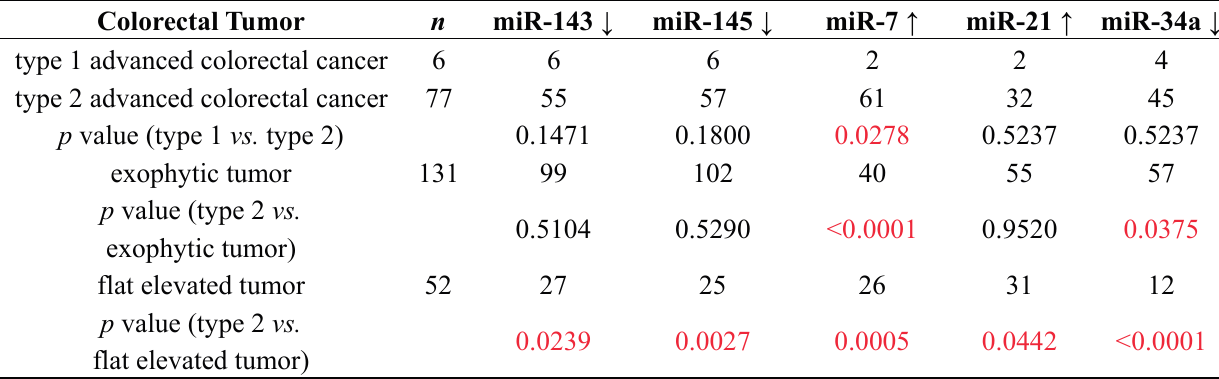
Table 6. Expression of miR-143, -145, -7, -34a, and -21 in human colorectal tumor tissues (advanced cancer types 1 and 2; exophytic tumor; flat elevated tumor).